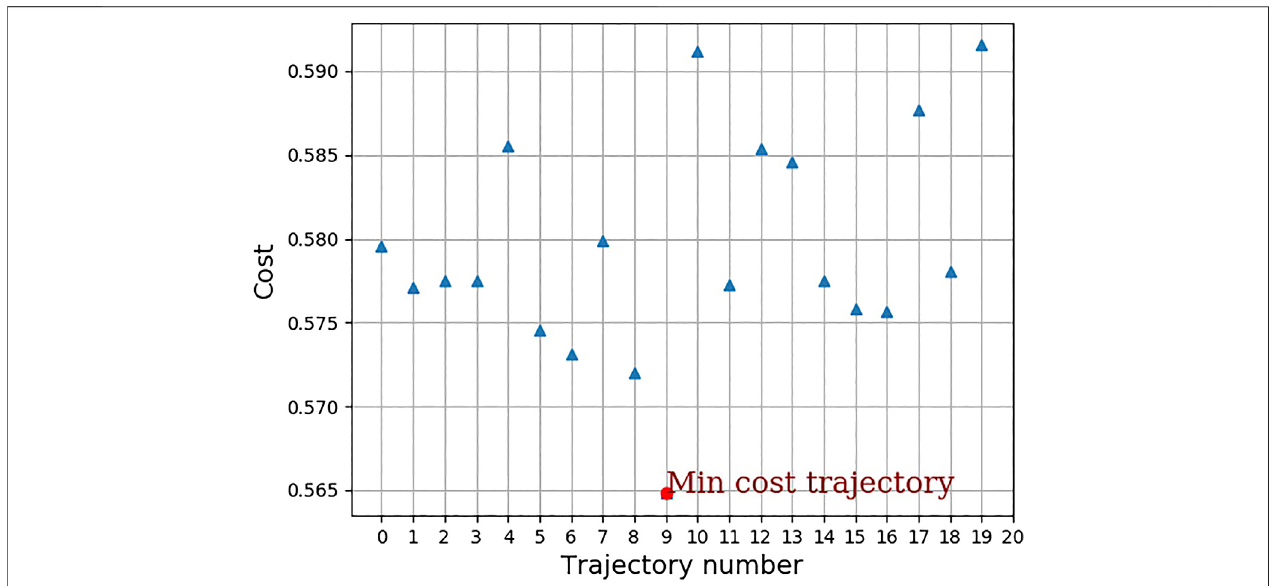
FIGURE 6 | Cost associated with each of the sampled